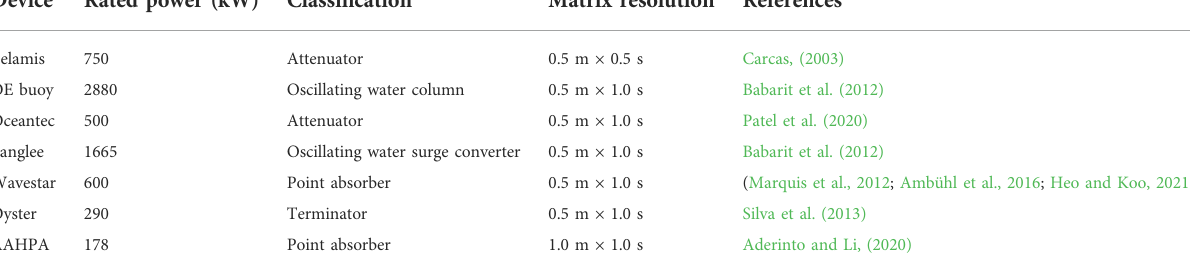
TABLE 1 Main characteristics of the WECs